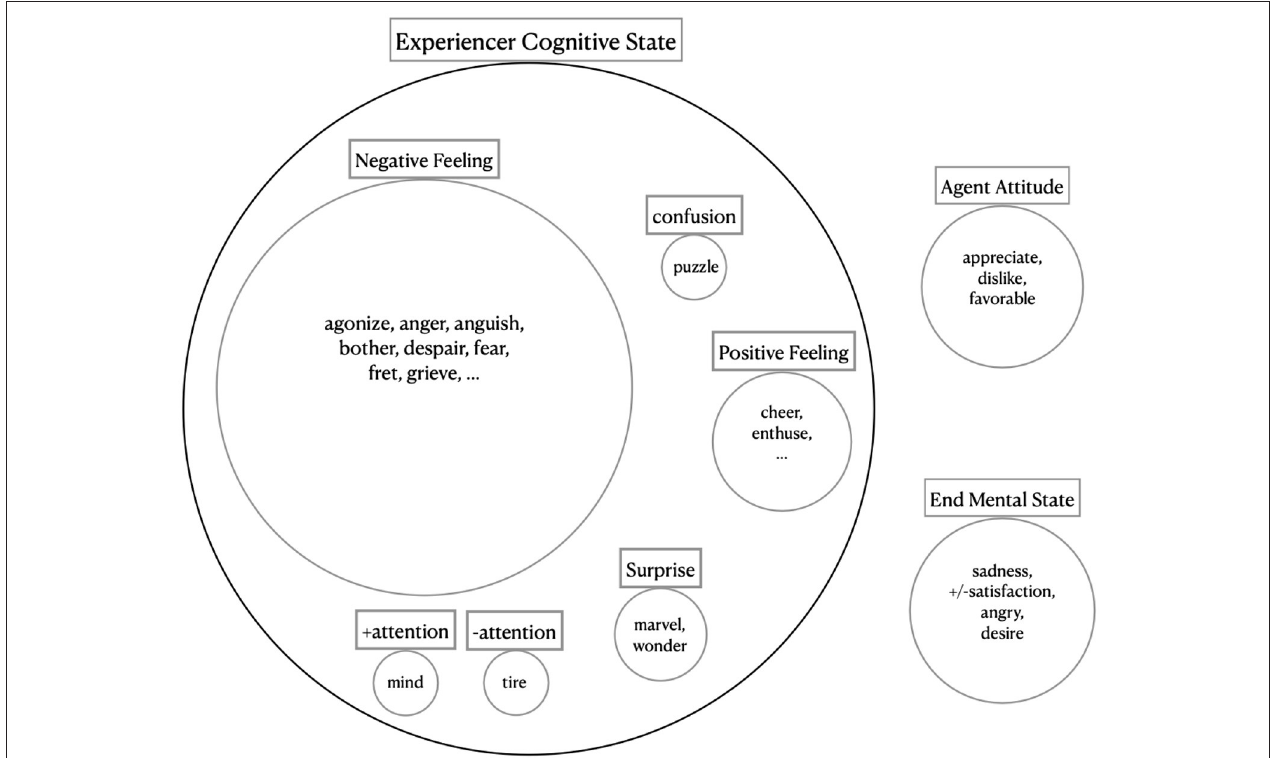
FIGURE 8 | A summary of the verb specific semantic features in the Marvel-31.3 VN class.